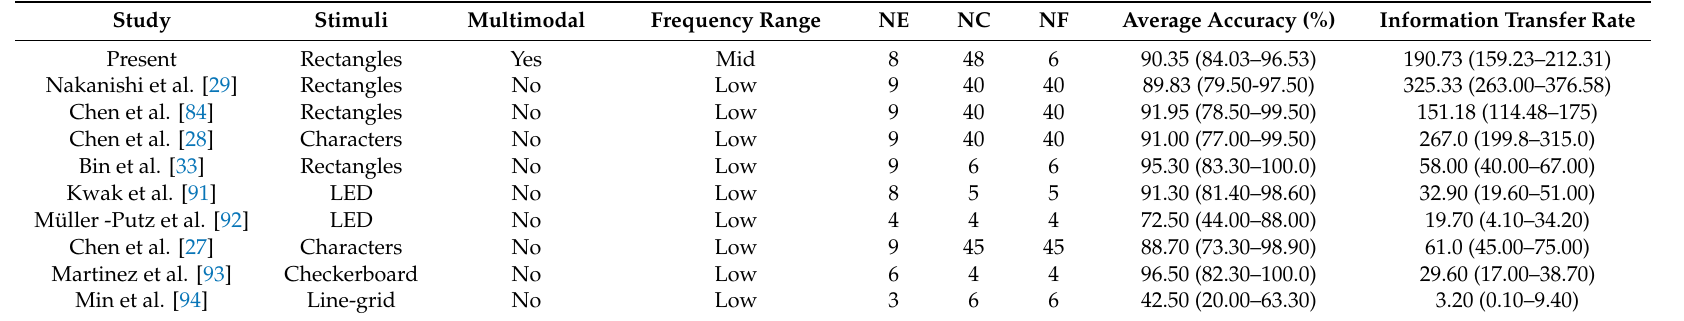
Table 5. Comparison of the present study with recent SSVEP-based BCI